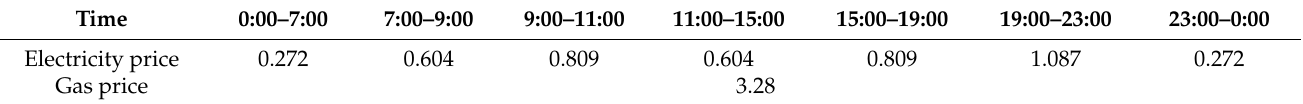
Table 1. Peak and valley electricity price and gas price table in Changsha city (Unit: CNY).